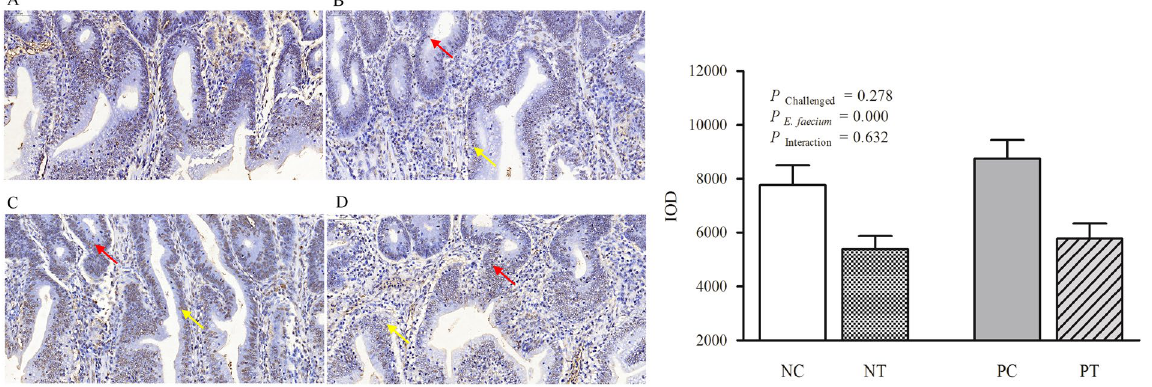
Figure 6. Effect of dietary E . faecium 11181 on the percentage of TUNEL-positive cells in the jejunum of broiler chickens challenged with NE at d 26 (7 DPI). A TUNEL assay in jejunum sections after 7 days of NE infection in broiler chickens from ( A ) the NC group, ( B ) the NT group, ( C ) the PC group, and ( D ) the PT group. The blue color represents the live cells in the jejunal villus, and the brown color represents the apoptotic cells. The red arrow points out a typical apoptotic cell in the jejunal crypt and the yellow arrow points out a typical apoptotic cell in the jejunal villus. ( E ) Integral optical density (IOD) of TUNEL expression. Values are means (n = 6) with the SEM represented by vertical bars. Magnification = 400 × .